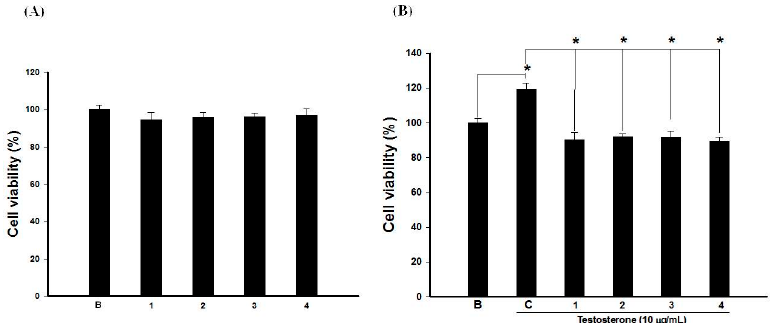
Figure 5. Cytotoxicity of different hydrolysable tannins ( A ); Anti-keratinocyte over-proliferative effects of hydrolysable tannins ( B ); B: blank; C: control; * p < 0.05, compared to the testosterone-only group; Data are presented as the mean ± SD; Significance was calculated using a one-way analysis of variance (ANOVA) via SPSS software v.15; Data are from three repeats.